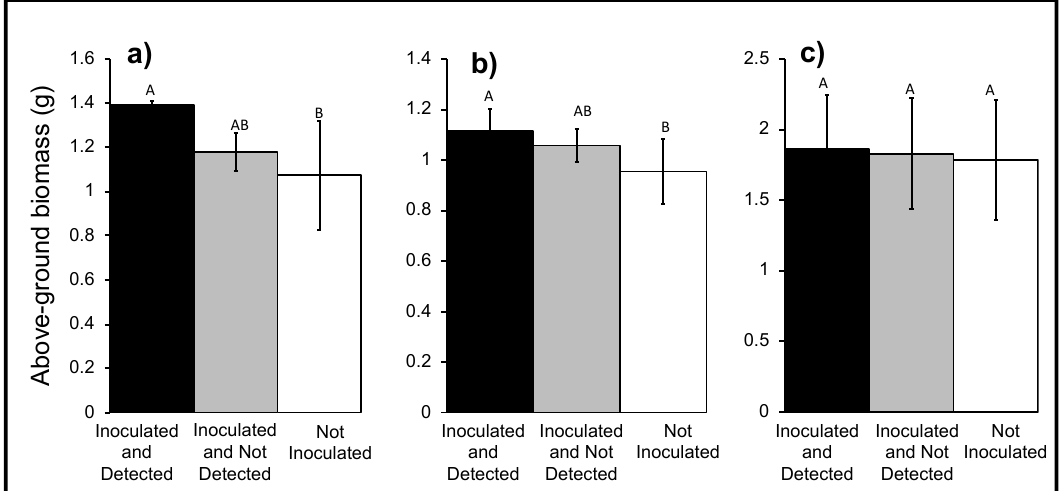
Figure 5. Mean above-ground dry biomass of ( a ) AWP ( n = 91), ( b ) cereal rye ( n = 113), and ( c ) canola ( n = 75) plants. Aboveground biomass was measured at 30 DAG by drying at 60 °C for 10-14 days. Error bars represent ± standard error of the mean. The bars sharing common letters are not significantly different within a cover crop species.